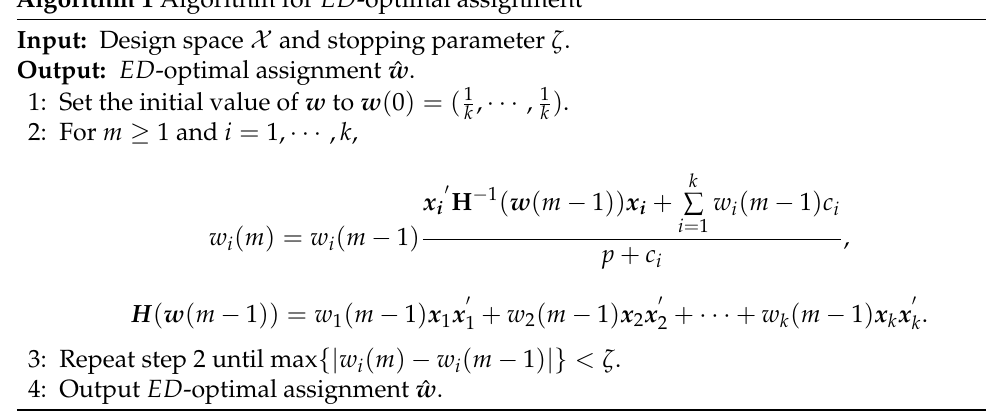
Algorithm 1 Algorithm for ED -optimal